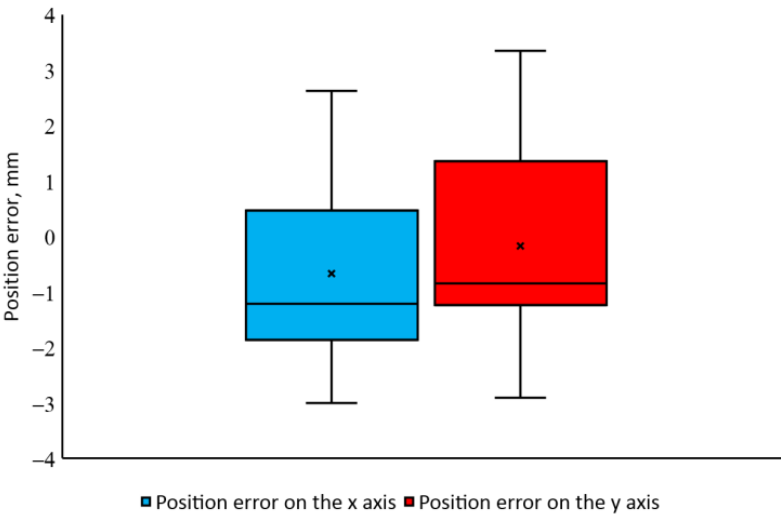
Figure 20. Errors of putting the object off in relation to the x and y axis of precision tests.